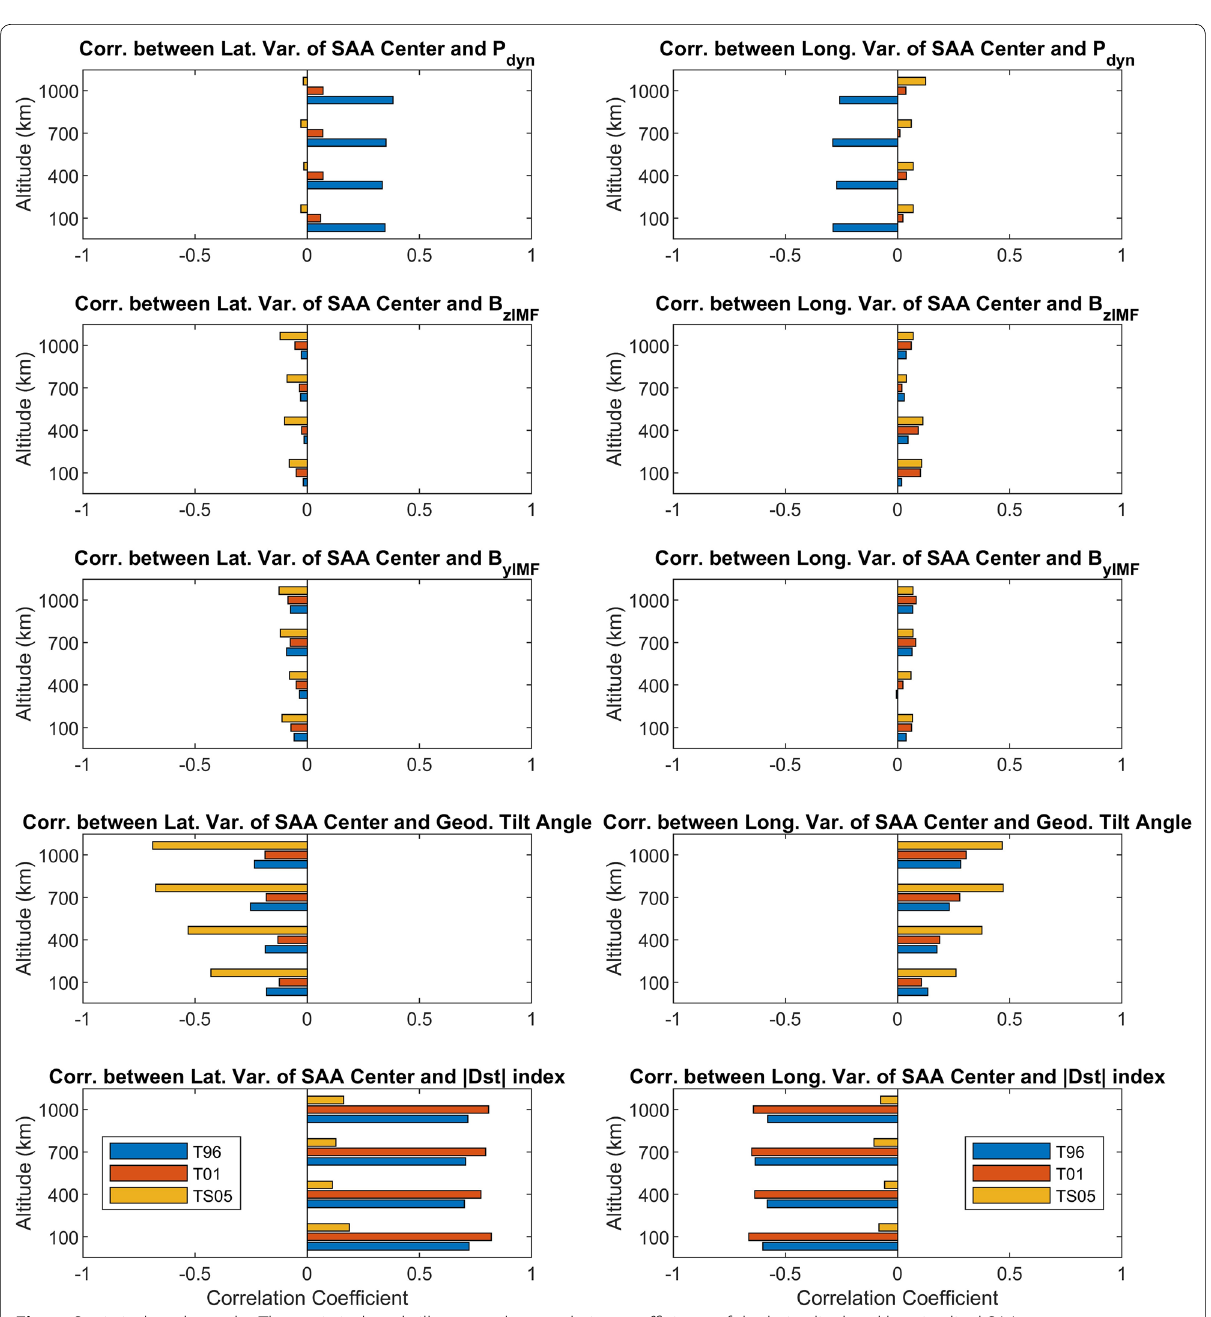
Fig. 4 Statistical study results. The statistical study illustrates the correlation coefficients of the latitudinal and longitudinal SAA center movements according to altitude for the Tsyganenko models, T96, T01 and TS05, referencing the different space weather